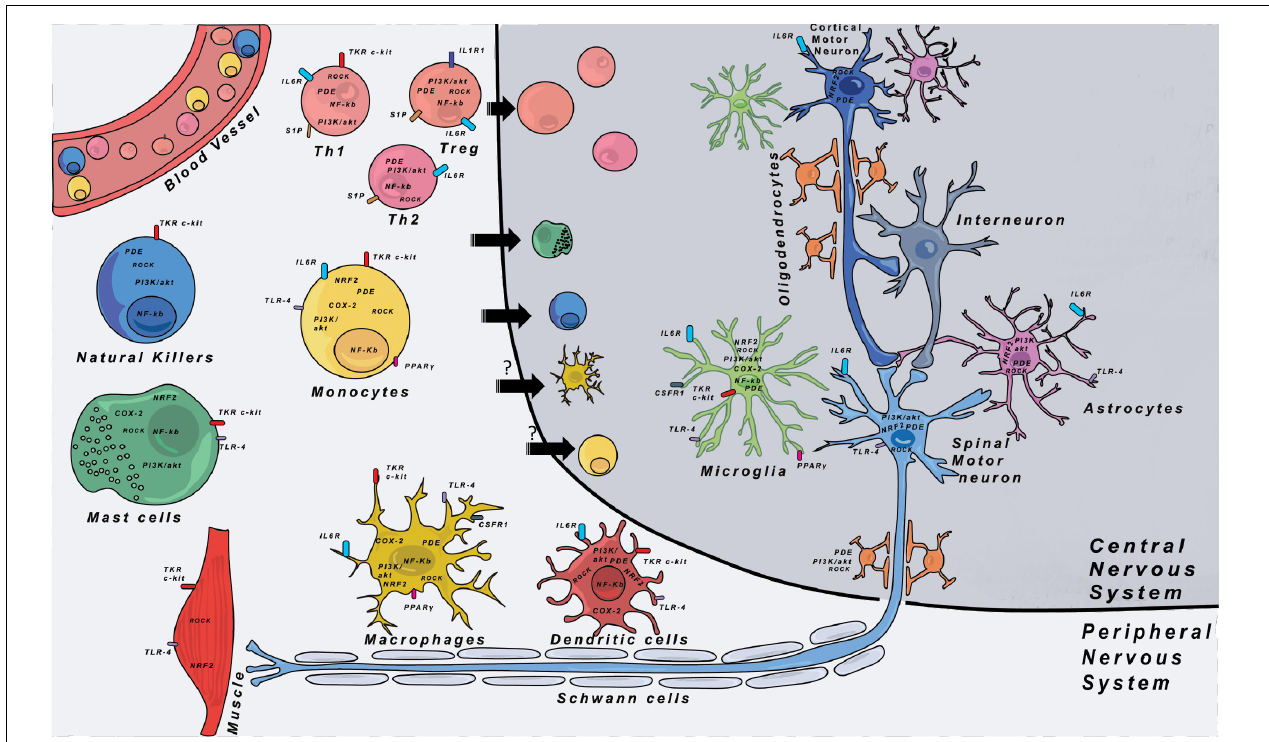
FIGURE 1 | Immune cells and their respective locations in the CNS and PNS. Major therapeutic targets are shown and are located either on the cell membrane or in the cytoplasm of cells. The expression of the different targets was indexed through researches with proteinatlas.org. COX-2, cyclooxygenase-2; CSF1R, colony stimulating factor 1 receptor; IL-1R1, interleukin-1 receptor 1; IL-6R, interleukin-6 receptor; NF- κ B, nuclear factor kappa-light-chain-enhancer of activated B cells; NRF2, nuclear factor erythroïd-2-related factor 2; PDE, phosphodiesterase; PGE2, prostaglandin E2; PI3K, phosphoinositide 3-kinase; PPAR γ , peroxisome proliferator-activated receptor gamma; ROCK, Rho-associated protein kinase; S1P, sphingosine-1-phosphate receptor; TKR, tyrosine-kinase receptor; TLR-4, Toll-like receptor 4.